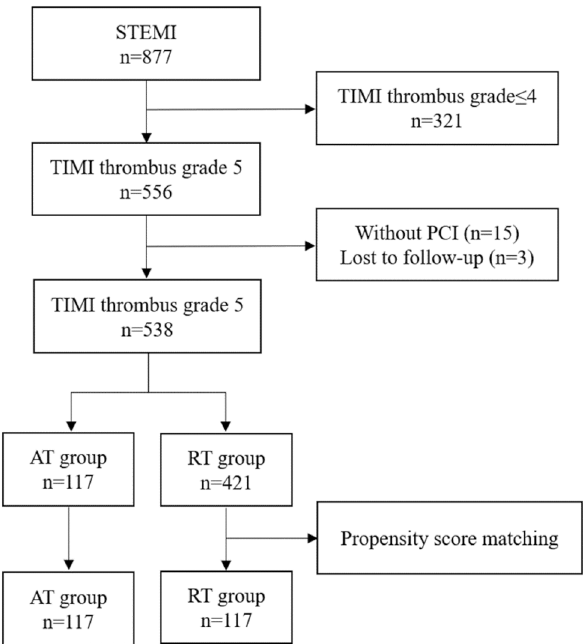
Figure 1. Study population. STEMI ST-segment elevation myocardial infarction, TIMI thrombolysis in myocardial infarction, PCI percutaneous coronary intervention, AT AngioJet rheolytic thrombectomy, RT routine treatment.